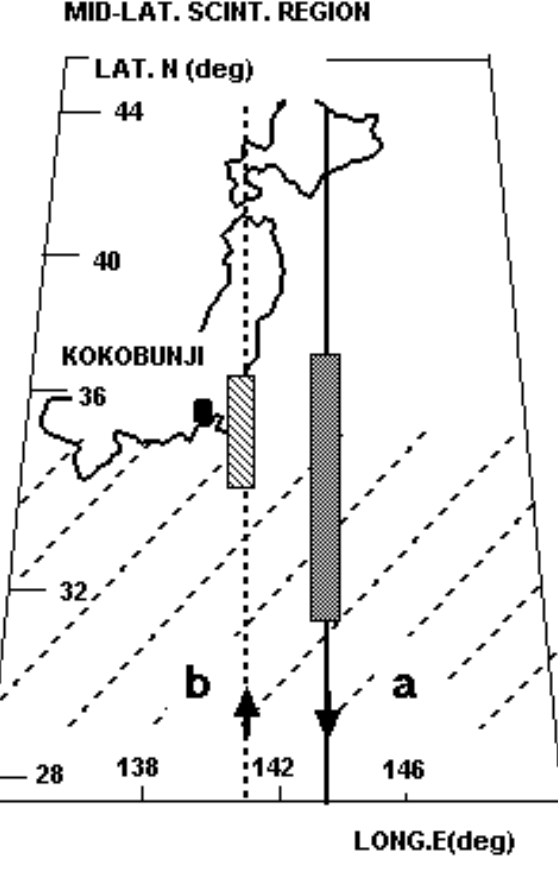
Fig. 2. The sub-ionospheric positions of scintillation regions as de- picted in Fig. 1 during day (b, at the E-region) and night (a, at the F-region). The shaded area refers to the most prevailing location of summer night scintillation activity, equatorwards of Kokobunji.